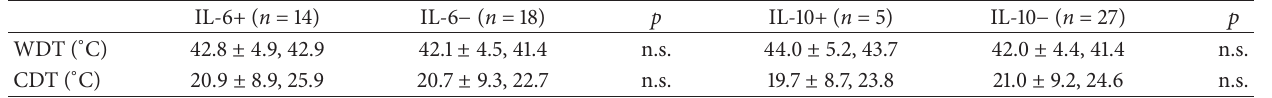
Table 3: Quantitative sensory testing